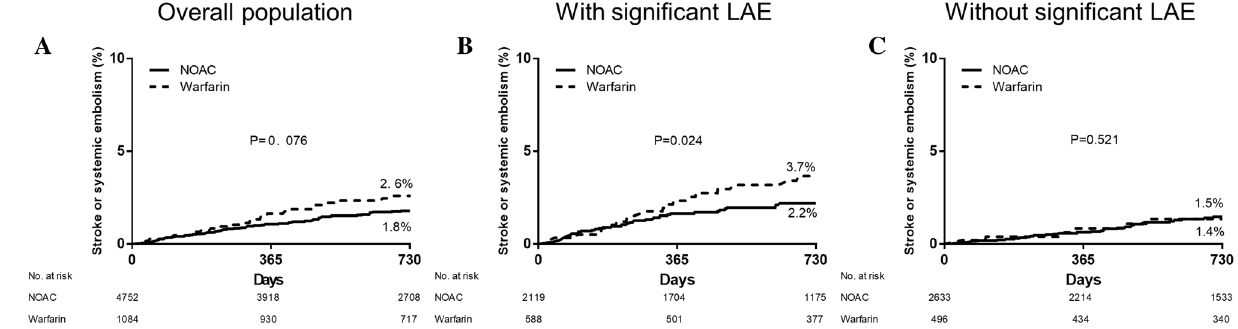
Figure 4. Influence of type of anticoagulation on the rate of stroke or systemic embolism stratified in ( A ) the overall population, ( B ) those with moderate to severe LAE, and ( C ) those without moderate–severe